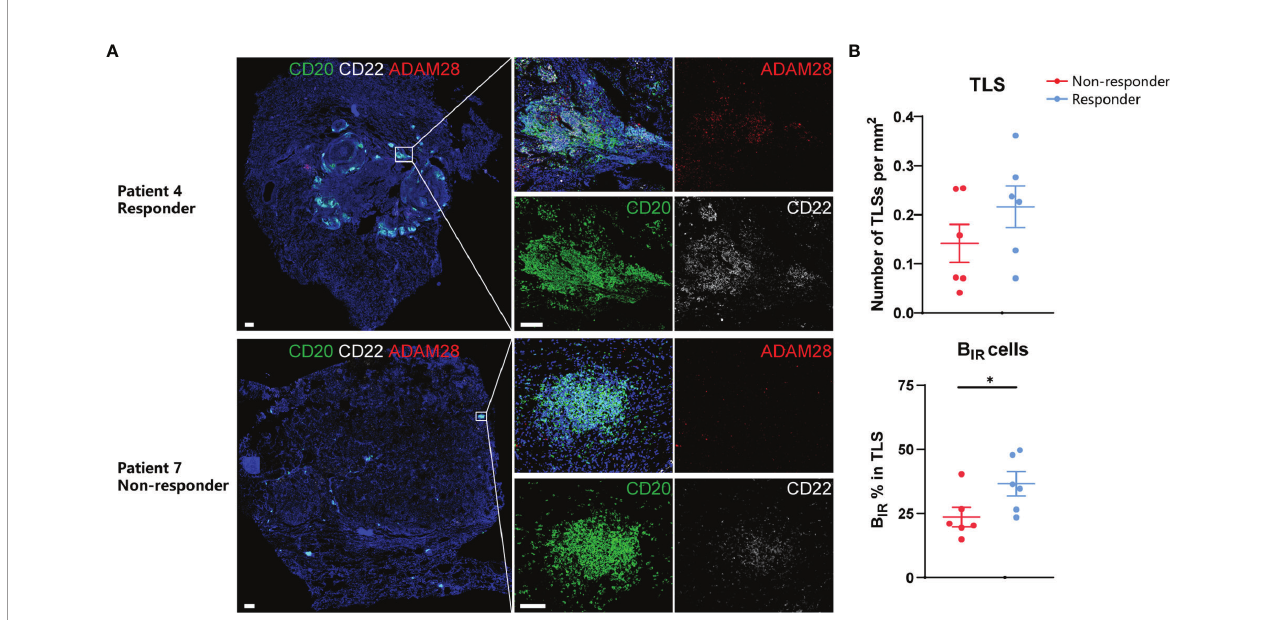
FIGURE 8 | Prognosis value of B IR cells in ICI-treated patients. (A) Representative immuno fl uorescence staining of B IR cells for CD20 (green),CD22 (white), and ADAM28 (red) from NSCLC patients response or no response to ICI therapy.All DAPI staining is shown in blue. Scale bar = 100m. (B) Quanti fi cation of TLSs density (up) and B IR cells percent in TLS (down) by immunohistochemistry and association with response to adjuvant ICI(n = 6 non-responders and 6 responders).Data are mean values ±SEM, and individual data points are shown.*P <